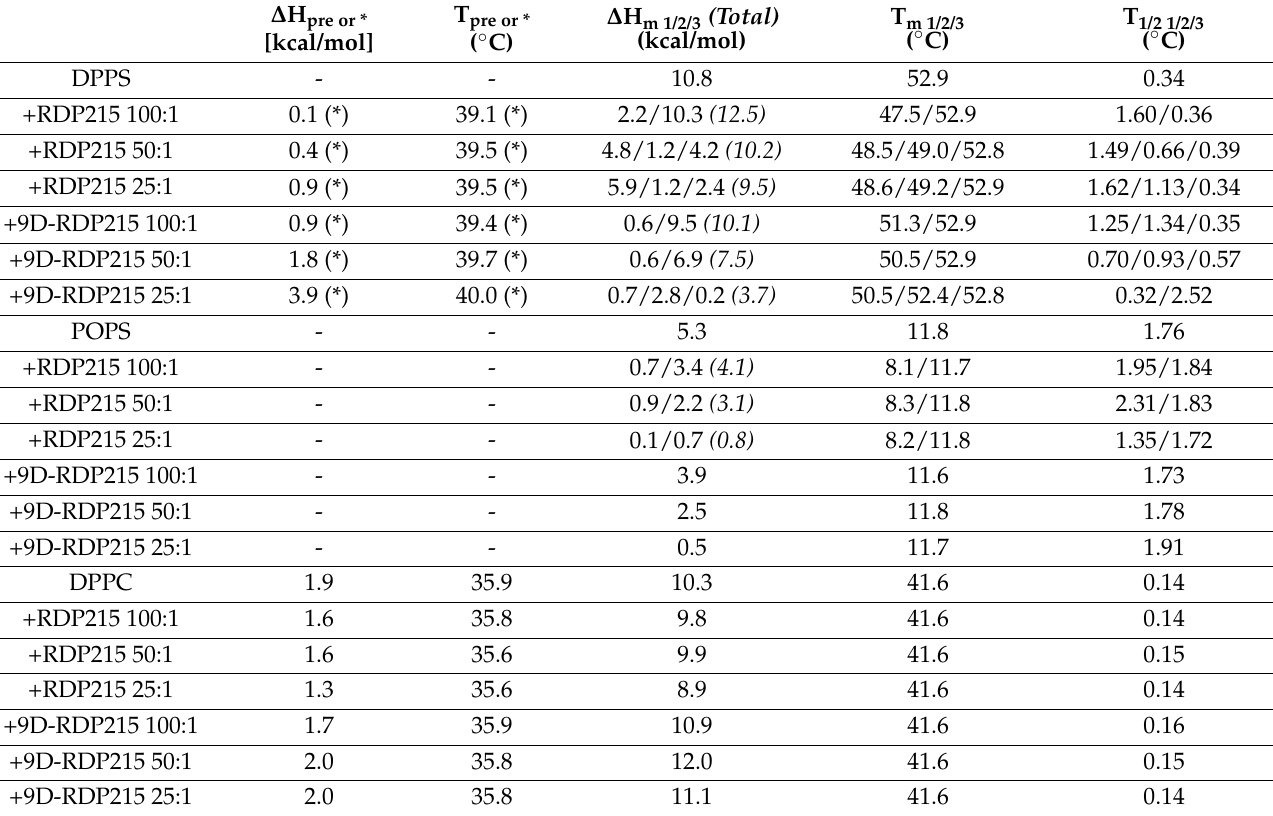
Table 3. Thermodynamic parameters of DPPS, POPS and DPPC liposomes in the absence and presence of RDP215 and 9D-RDP215 with different molar lipid-to-peptide ratios (100:1; 50:1; 25:1). DSC data analyzed with MicroCal Origin Software (VP-DSC version) are representative results of three independent experiments. Deconvolution was used for analysis of data with overlapping phase